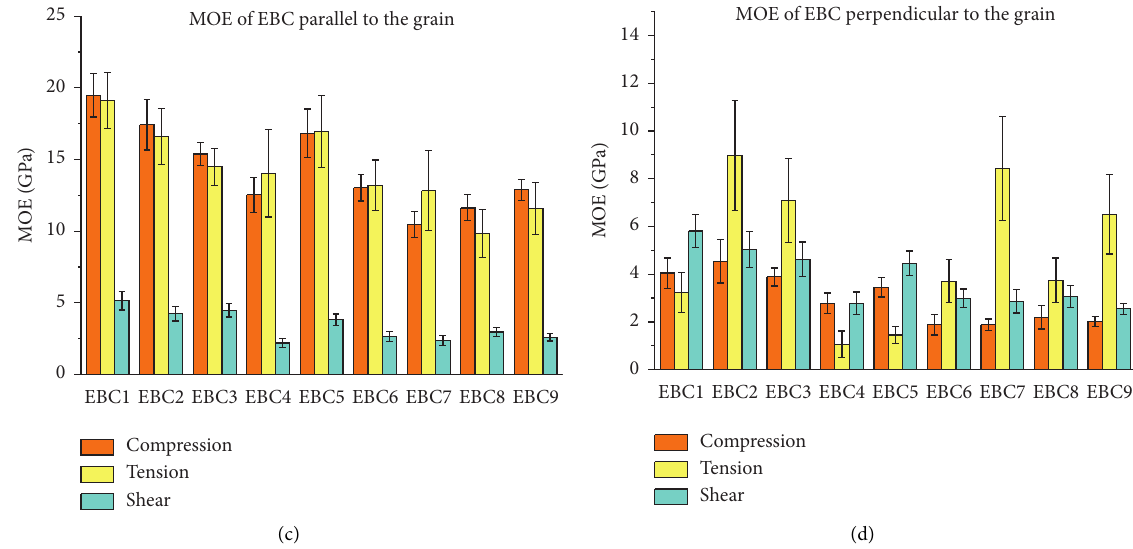
Figure 4: Strengths and moduli distributions of experimental data: strengths in parallel to the grain (a); strengths in perpendicular to the grain (b); moduli in parallel to the grain (c); moduli in perpendicular to the grain (d).